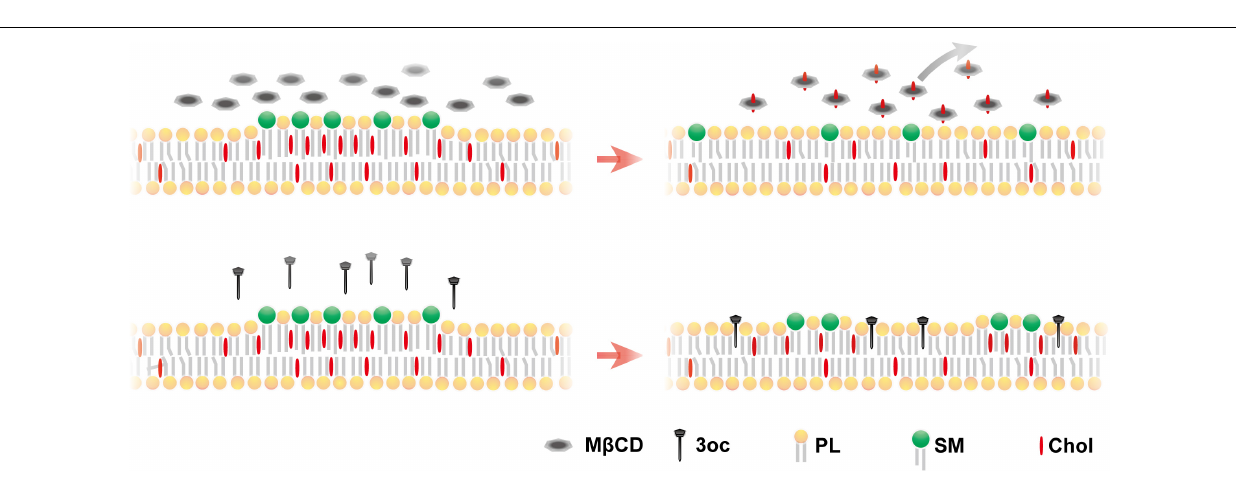
FIGURE 6 | Proposed mechanism for M β CD and 3oc disruption of the lipid-ordered domain. Upper panel: M β CD treatment produces a more homogeneous plasma membrane due to the extraction of lipid components. Lower panel: 3oc produces a more limited disintegration with small islands remaining, without affecting the plasma membrane components [(phospholipids